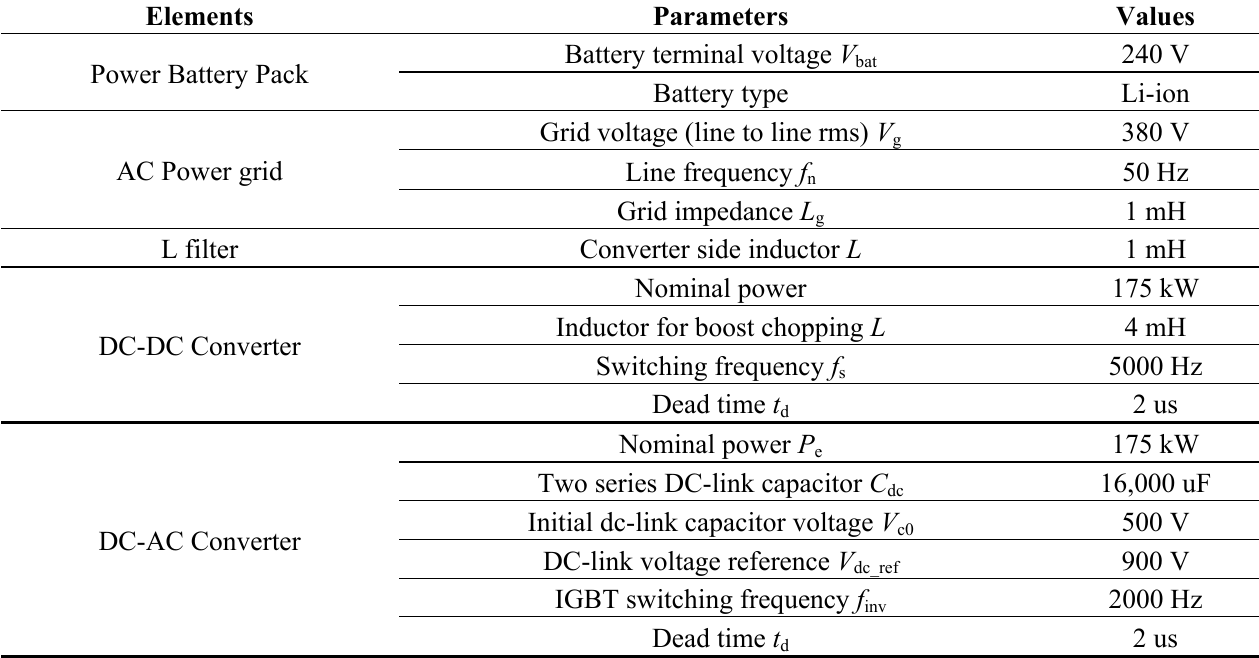
Table A2. Specifications adopted for the proposed ERLPABTS under discharging